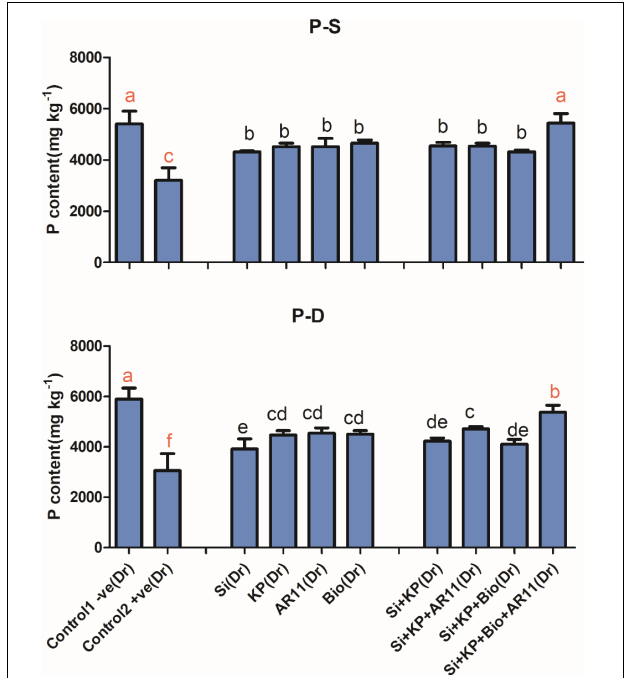
FIGURE 2 | Effects of AR11, Si, K 2 HPO 4 , and biochar inoculation on phosphorus content in rice shoots subjected to salt and drought stresses. (-S), salt; (-D), drought. Error bars represent standard deviations. Each data point represents the mean of at least three replications. Bars with different letters are significantly different from each other at P ≤